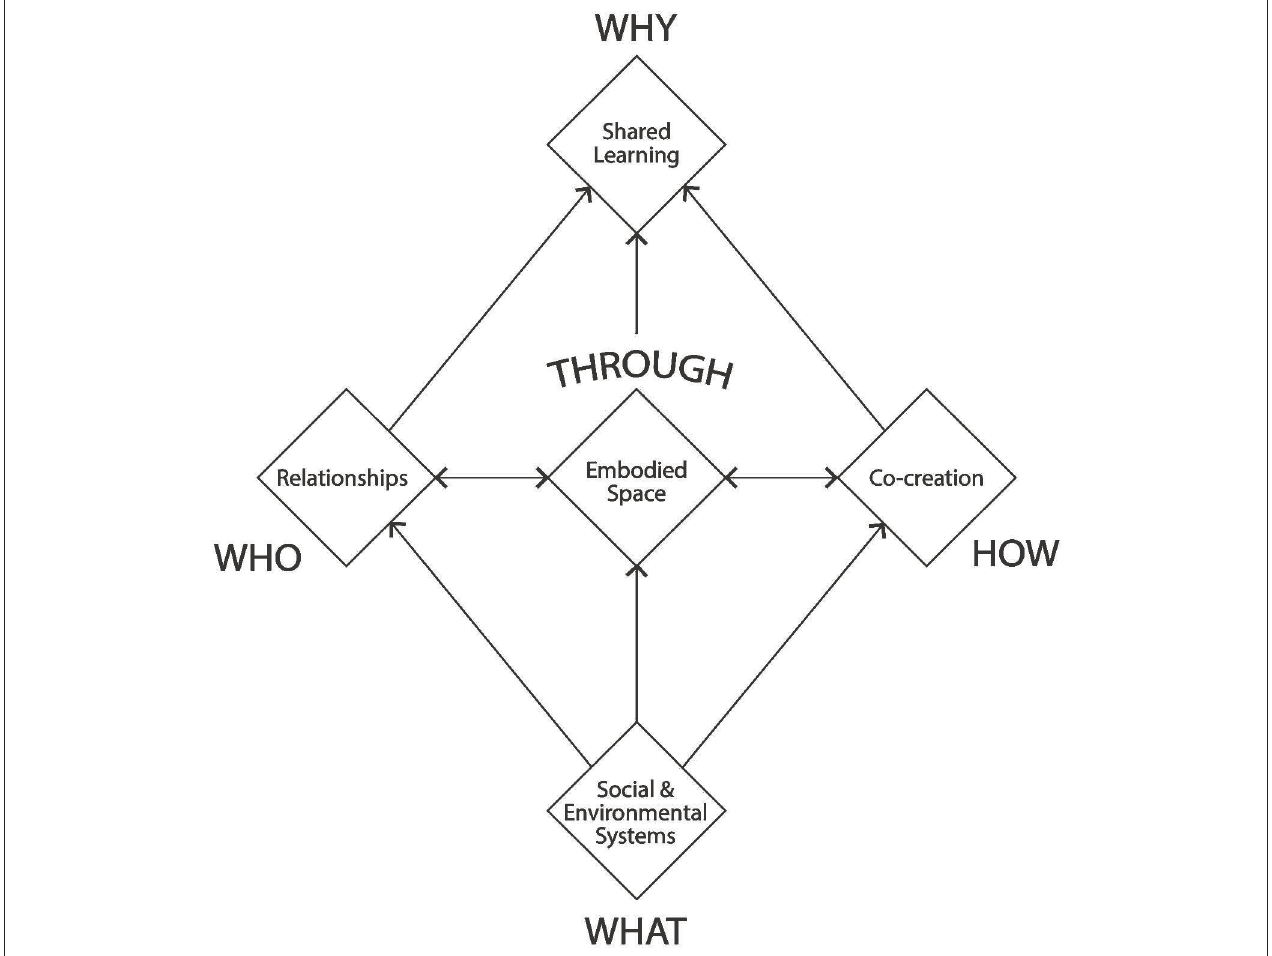
FIGURE 6 | “Learning Framework” for urban agroecology research. Building on themes that emerged from our evaluation ( Figure 2 ), we propose that “embodied space’’—consisting of embodied learning experiences and shared rituals/ceremonies—is necessary to connect relationships to co-creation of projects and processes. Through embodied space, interactions are facilitated that result in the emergence of transformative learning toward changing social and environmental systems.